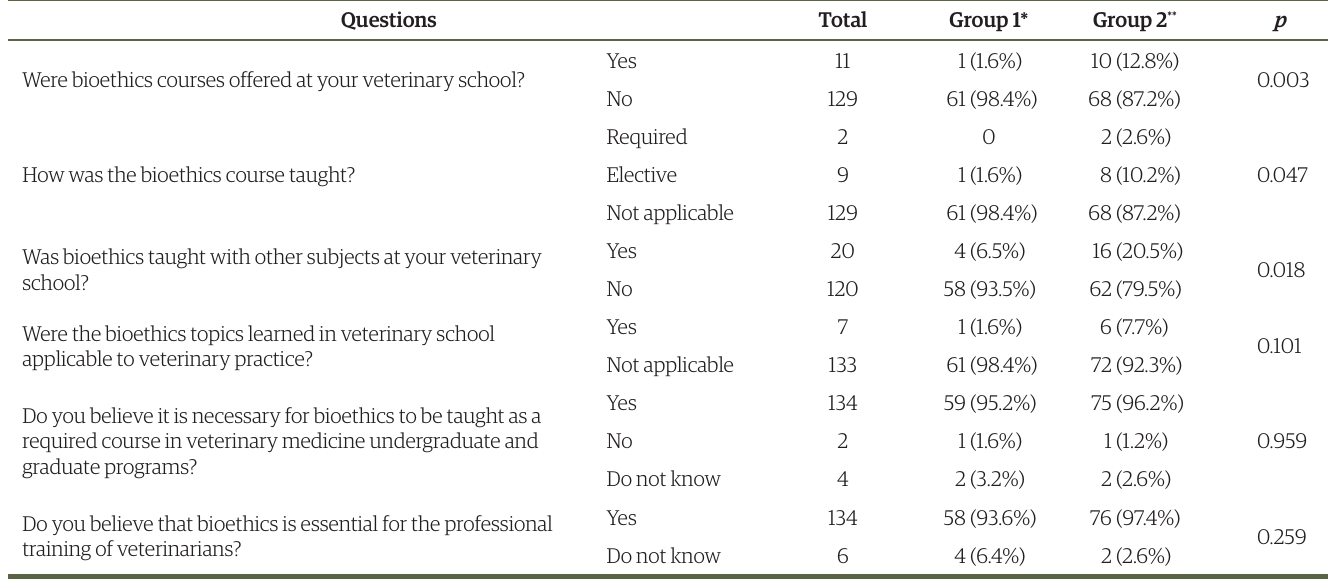
Table 1. Perception of bioethics training and practical application in professional practice per